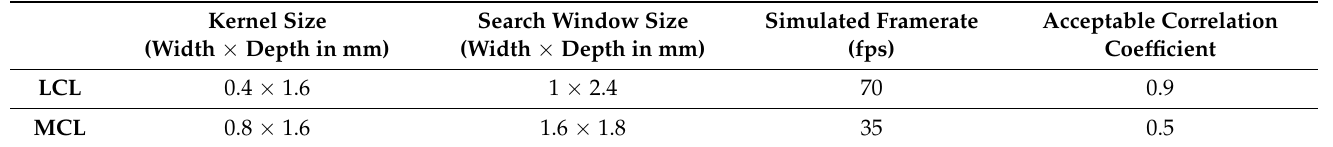
Table 2. Optimal values of kernel size (in mm), search window size (in mm), simulated frame rate (in frames per second) and acceptable correlation coefficient during tracking for both lateral collateral ligament (LCL) and medial collateral ligament (MCL).